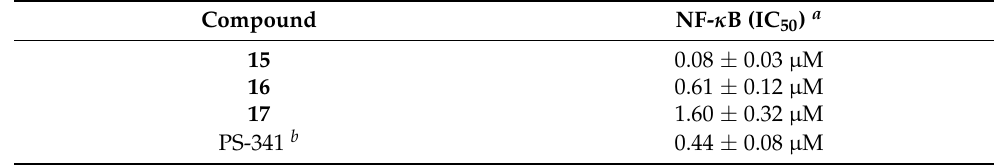
Table 4. Inhibitory activities of indicated compounds against NF- κ